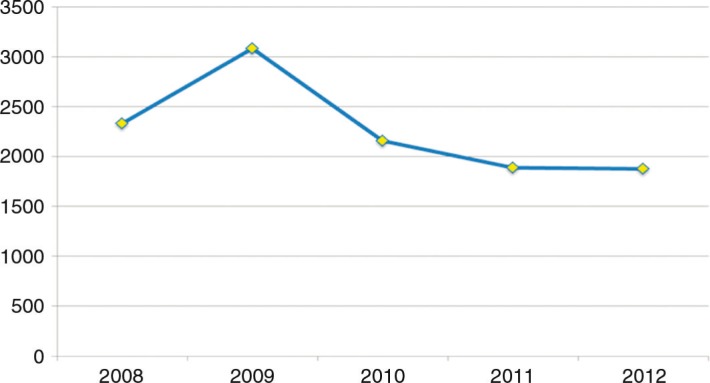
Incidence rate of ILI per 100,000 over the period 2008–2012.